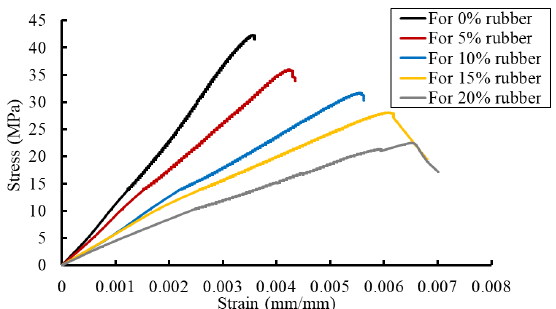
Figure 10. Effect of the CR content on the stress–strain relationships.